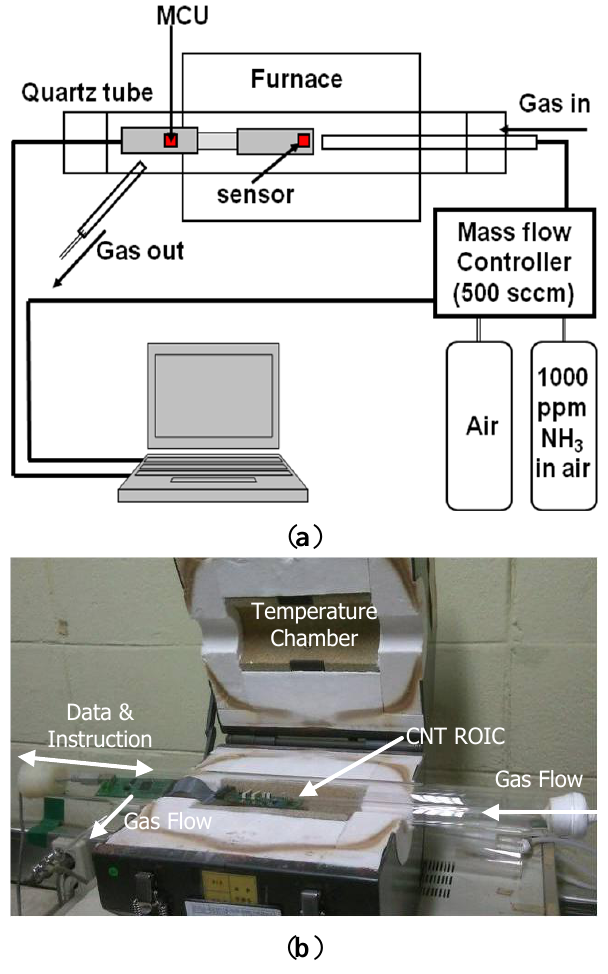
Figure 4. CNT sensor measurement system. ( a ) Schematic diagram showing the concept and operation of the temperature-controlled measurement system. ( b ) Photograph of the test equipment.